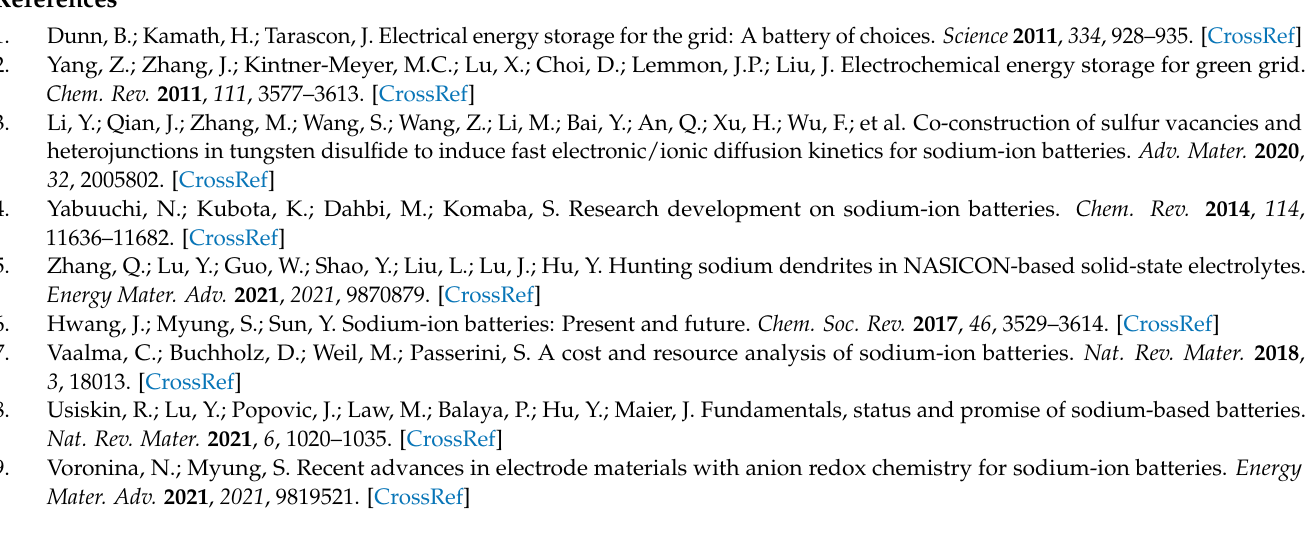
Table S1: The layer spacing and corresponding crystal information of ZrO 2 (PDF #49-1642); Table S2: BET results of HC and HC@ZrO 2 -1; Table S3: The electrochemical properties of HC and HC@ZrO 2 ; Table S4: ICE literature comparison of improving HC anode of SIBs by surface engineering; Table S5: The fitted results of the EIS plots using the equivalent circuit in Figure S5b. References [22–24,27,47] are cited in the supplementary